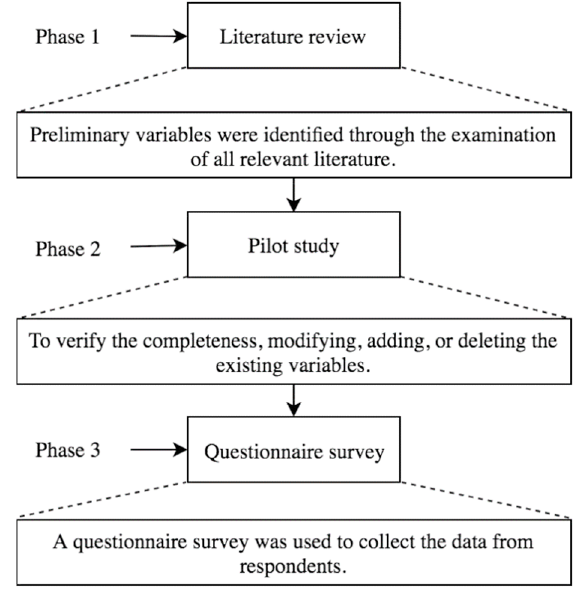
Figure 2. Data collection procedure.